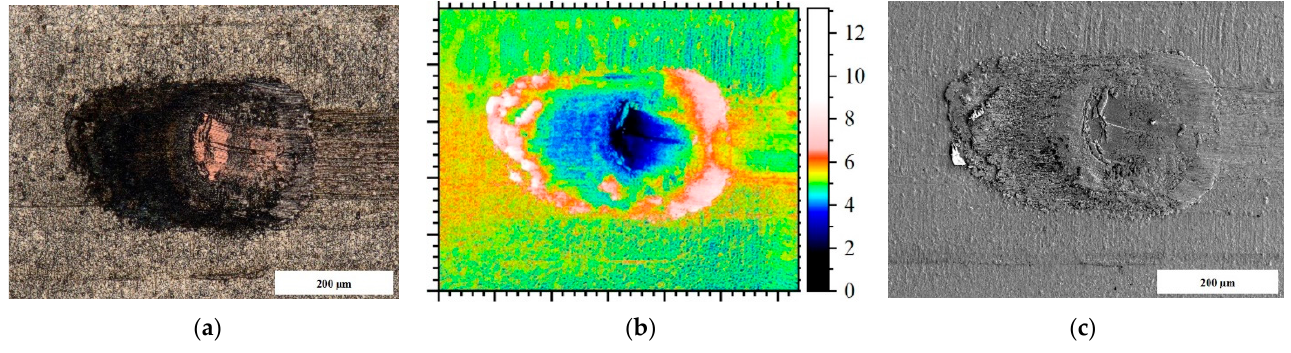
Figure 10. Comparison of imaging tools by analyzing an electrical connector after vibration and temperature cycling test: ( a ) Light Microscopy; ( b ) Topographic Measurement; ( c ) Scanning Electron Mircroscope (acceleration voltage 5 kV, detection: SE).